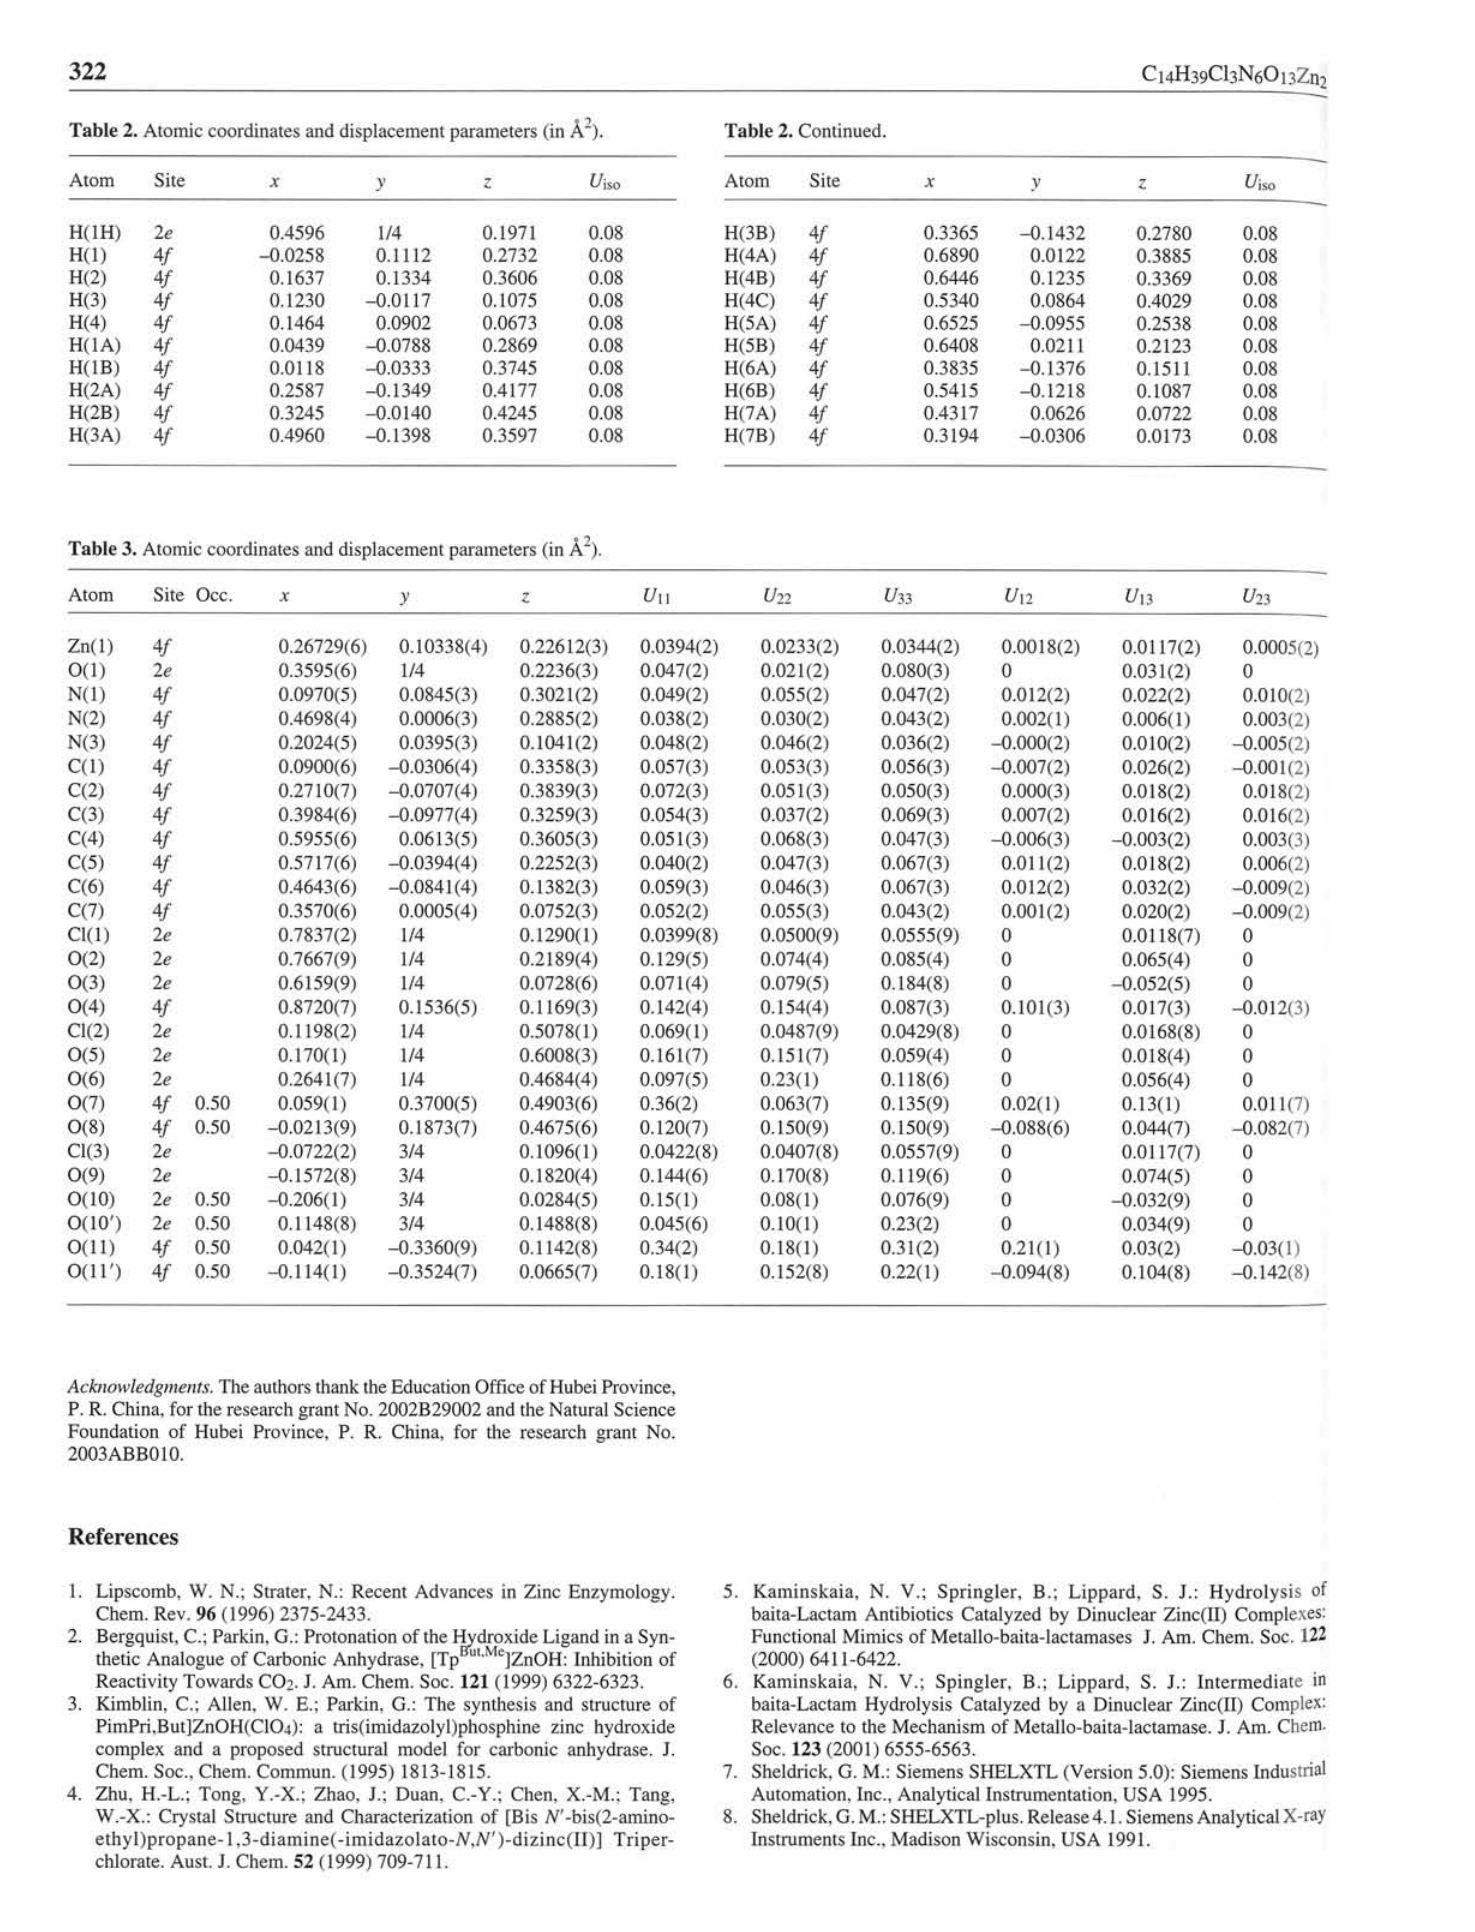
Table 3. Atomic coordinates and displacement parameters (in A 2